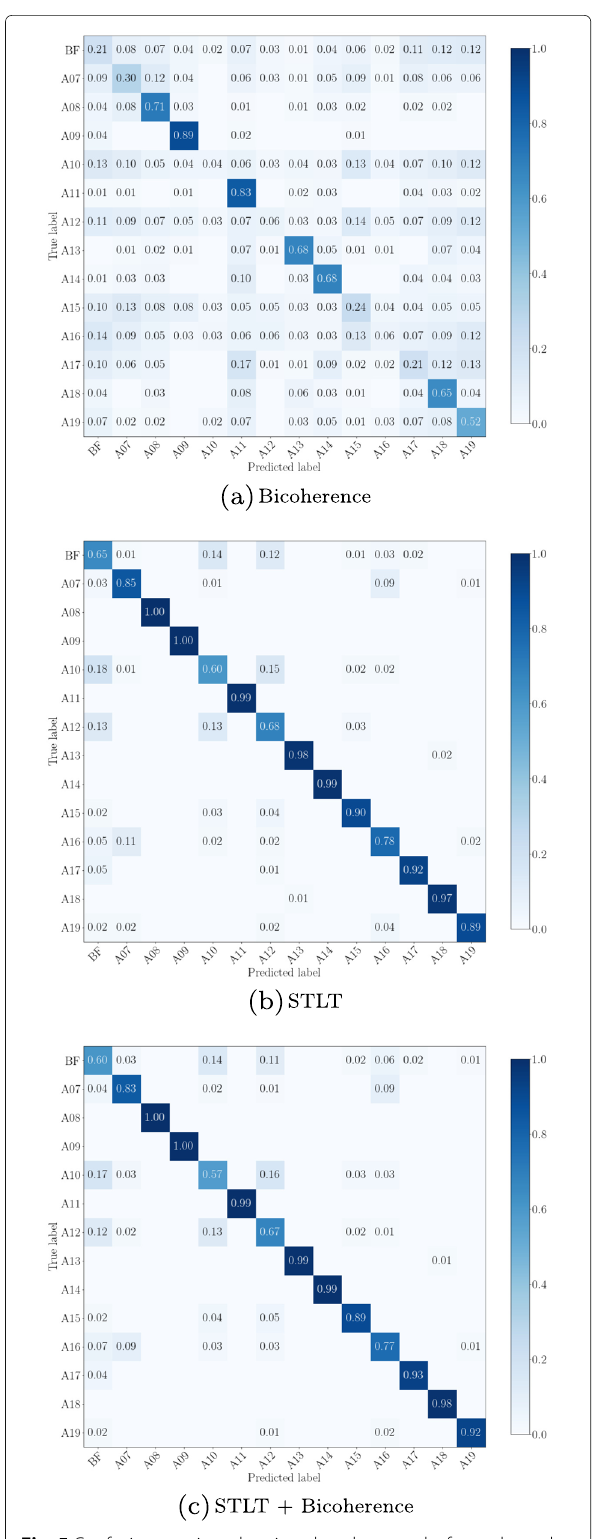
Fig. 5 Confusion matrices showing closed-set results for each used feature vector on dataset D